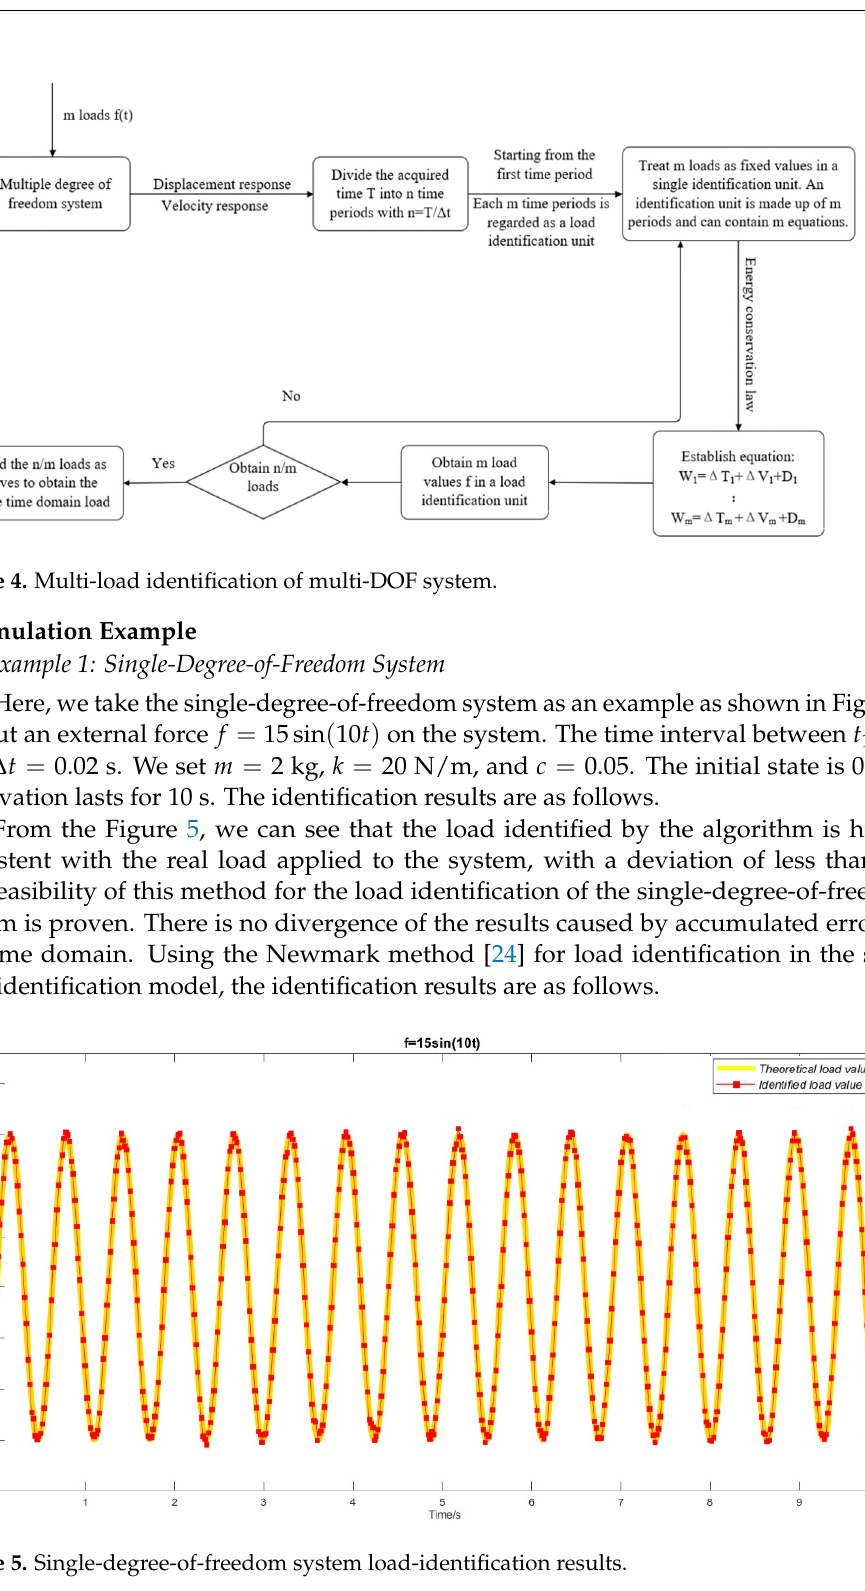
Figure 6. Load identification error comparison with Newmark method. 3.2. Multiple-Degree-of-Freedom System Case 1: In this example, we take the multiple-degree-of-freedom system shown in Figure 3 as a research object and identify the dynamic load on it. We set the stiffness of the